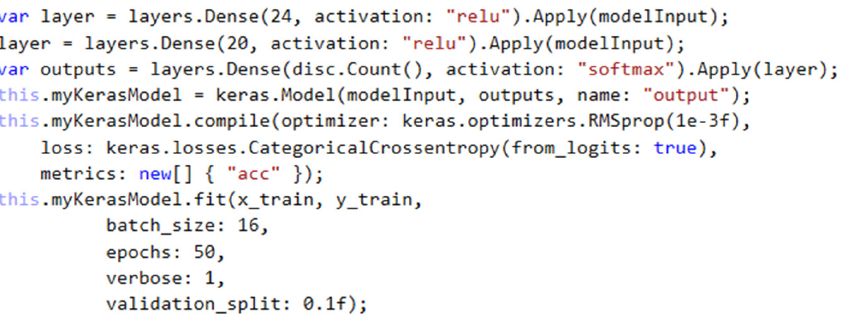
Figure 8. Code sample of a Tensorflow model creation (own creation).